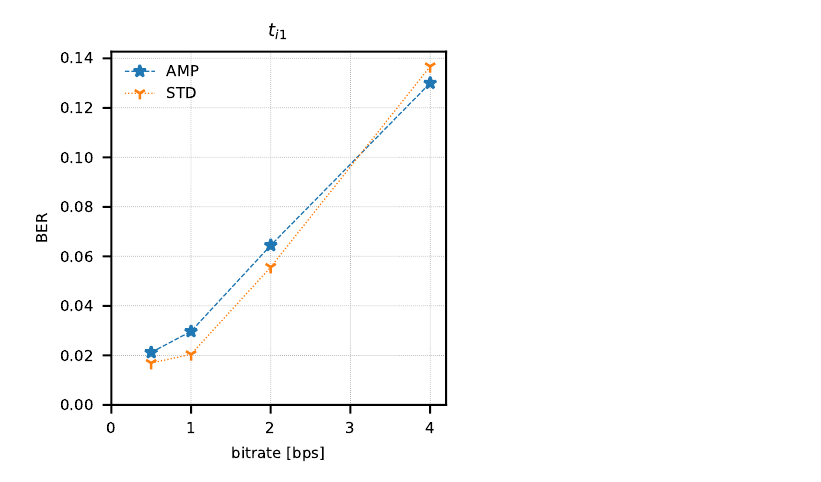
Figure 14. Bit error rate values as a function of bit rate and analysis method (AMP—amplitude analysis, STD—variance analysis) for t i 1 integration time set.